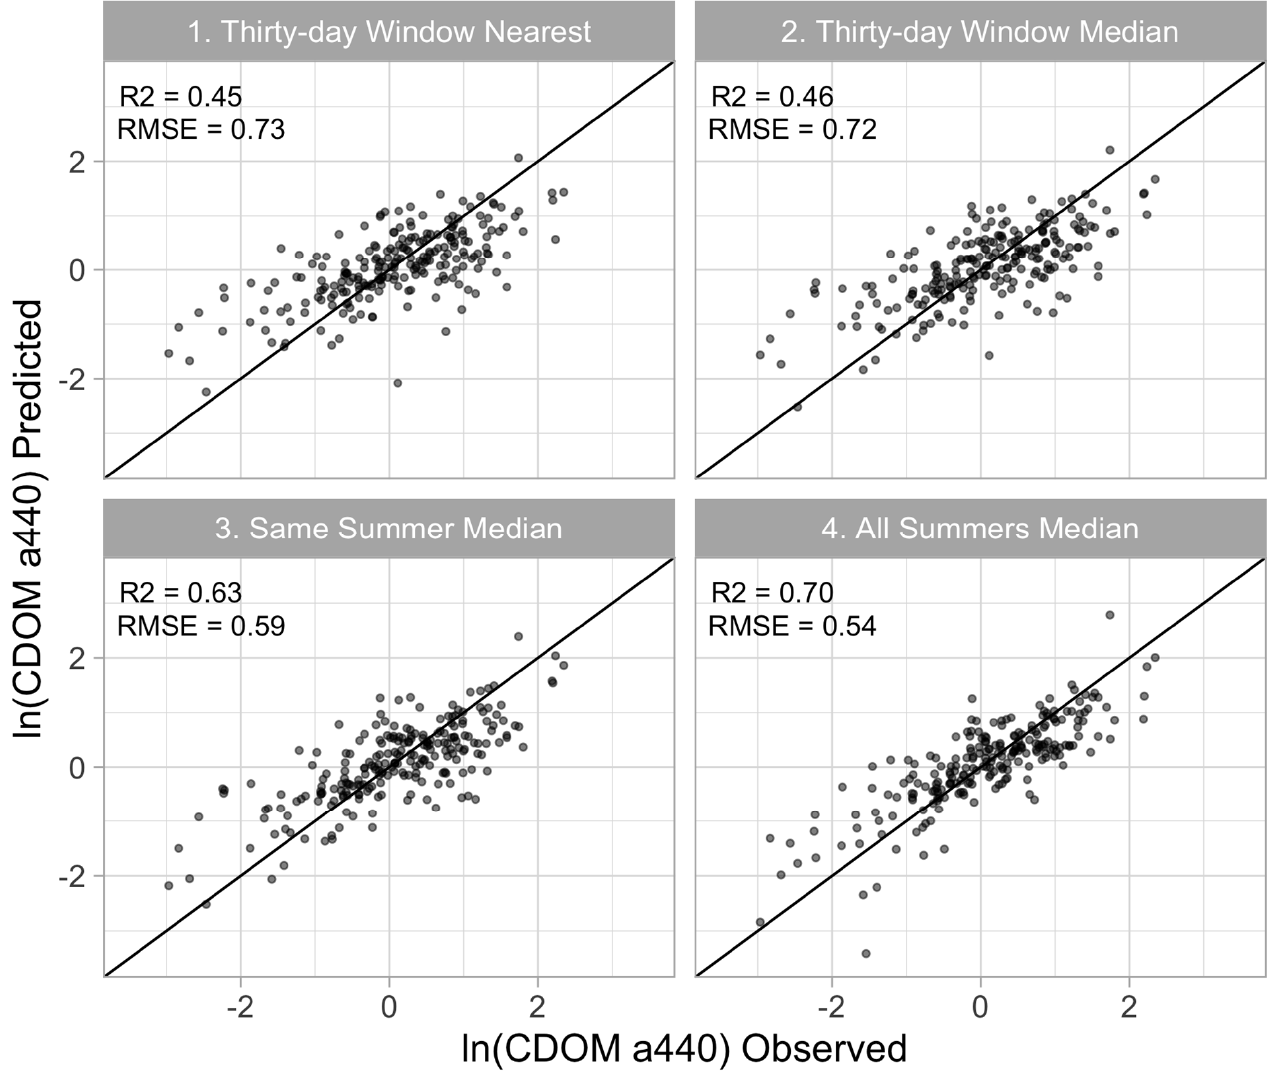
Figure 4. Predicted versus actual plots for CDOM( a 440 ) regression in the calibration lakes ( n = 233). Model fit in the calibration lakes improved markedly by including more imagery from a model made with one curated image for each lake. Improving fits are shown using the median of images in the given 30-day period (panel 2); images from the same summer as the field sample (panel 3); and images from all summers in which Landsat 8 was collected (panel 4). Diagonal lines represent the 1:1 line.